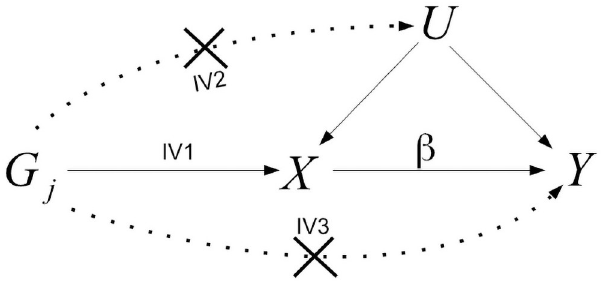
Fig 1. The IV assumptions for a genetic variant G are represented by solid lines in the directed acyclic graph (DAG). Dotted lines represent violations of IV assumptions as described in IV2 and IV3. The causal effect of a unit increase of the exposure, X , on the outcome, Y , is denoted by β . U represents unobserved confounders of X and Y .